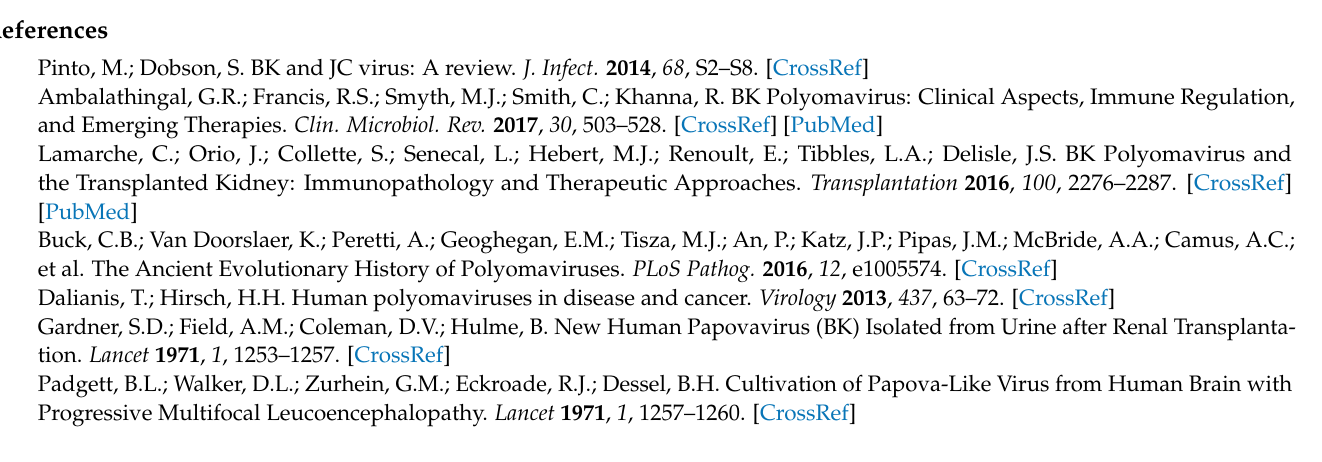
results. Figure S2: Electrophoretic separation of amplification products obtained in a reaction with primers flanking the fragment encoding the VP1 protein of the BK polyomavirus. The presence of a light 327 bp band indicates the presence of the genetic material of the virus in the sample. Separation was carried out in 2% agarose gel. Own results. Figure S3: qPCR, allowing for quantification of the viral load in the sample, together with the standard curve based on amplification of four standard samples. qPCR amplification prepared with the GeneProof BK/JC Virus (BK/JC) PCR Kit. Own